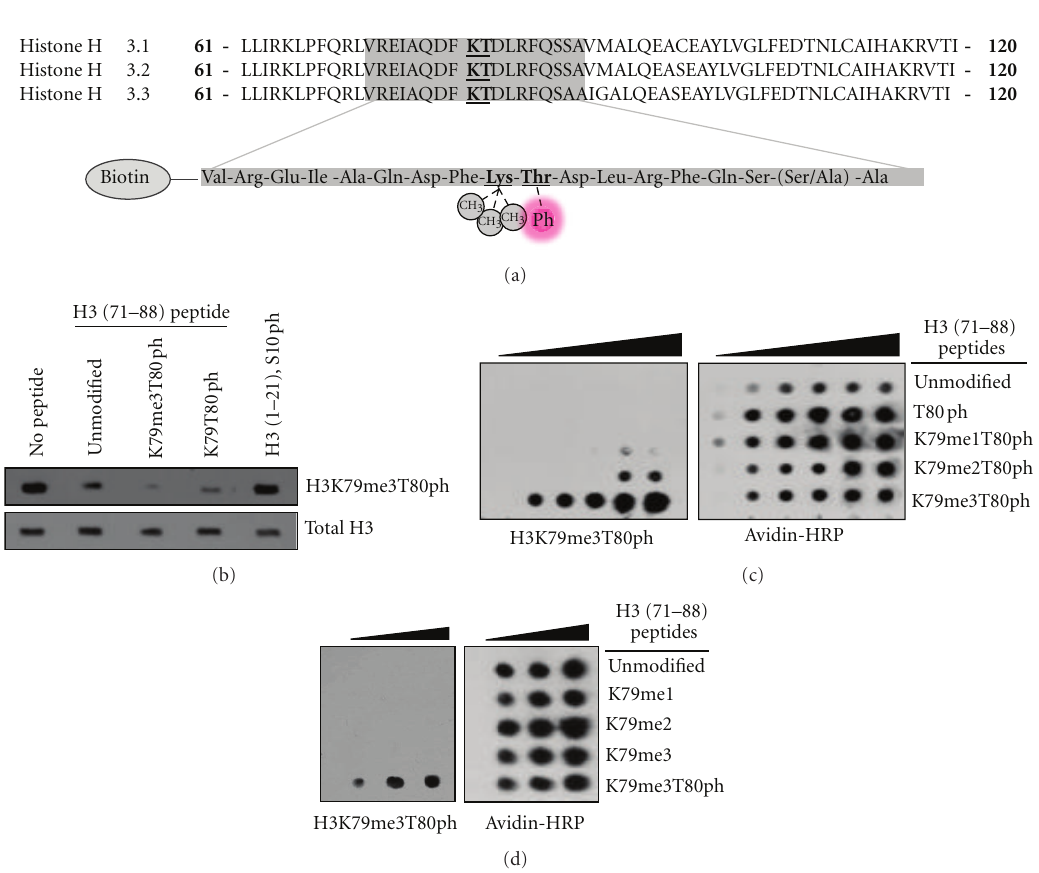
Figure 1: H3K79me3T80ph antibody specificity. (a) Shown are the three H3 isoforms and their amino acid sequence in the core of the protein surrounding lysine 79 and threonine 80 (emphasized) (top), and the biotinylated peptides designed for this study that are either unmodified, contain mono-, di-, or trimethylation of K79 plus phosphorylated T80, or phosphorylated T80 alone (bottom). (b) Histones from HeLa cells were isolated and subjected to western blotting with the H3K79me3T80ph antibody alone (no peptide) or in the presence of 15 μ M of biotinylated H3 (71–88) peptides with no modification, K79 trimethylation and T80 phosphorylation, T80 phosphorylation alone, or an H3 (1–21) S10ph peptide. (c) 50, 100, 150, 200, 250nmoles of biotinylated H3 (71–88) peptides containing mono-, di-, or trimethylated K79 in conjunction with T80 phosphorylation were spotted onto nitrocellulose and subjected to H3K79me3T80ph and Avidin-HRP western blotting. (d) 50, 100, 150, 200, 250nmoles of biotinylated H3 (71–88) peptides with K79 trimethylation and T80 phosphorylation or